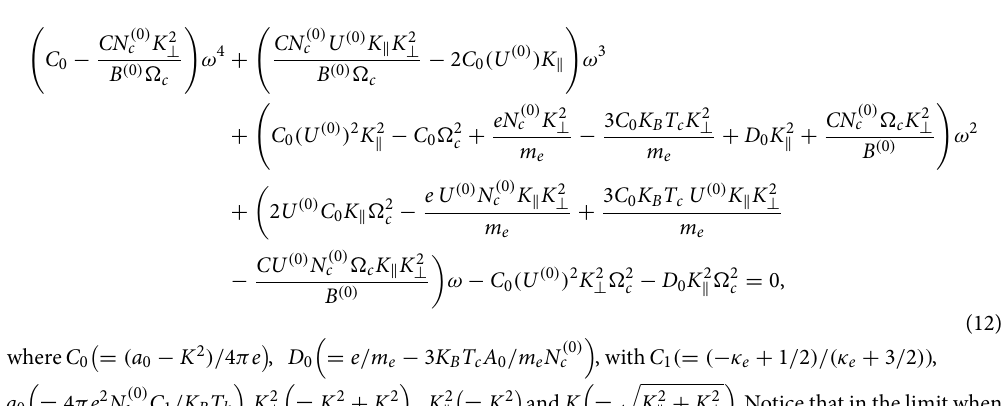
10 12 rad / s ) in Eq. (12), is plotted ω (where ω ω/ω 0 with ω 0 ¯ ¯ = = 10 6 cm − 1 ) with variation in ( a ) streaming speed K / K 0 with K 0 = = 10 3 cm s − 1 (dashed curve) and 3 10 3 cm s − 1 (dotted curve). The same × × 10 5 G (dashed curve) and 3 × 3 10 3 K ( T h 10 4 K ) and κ e = = =